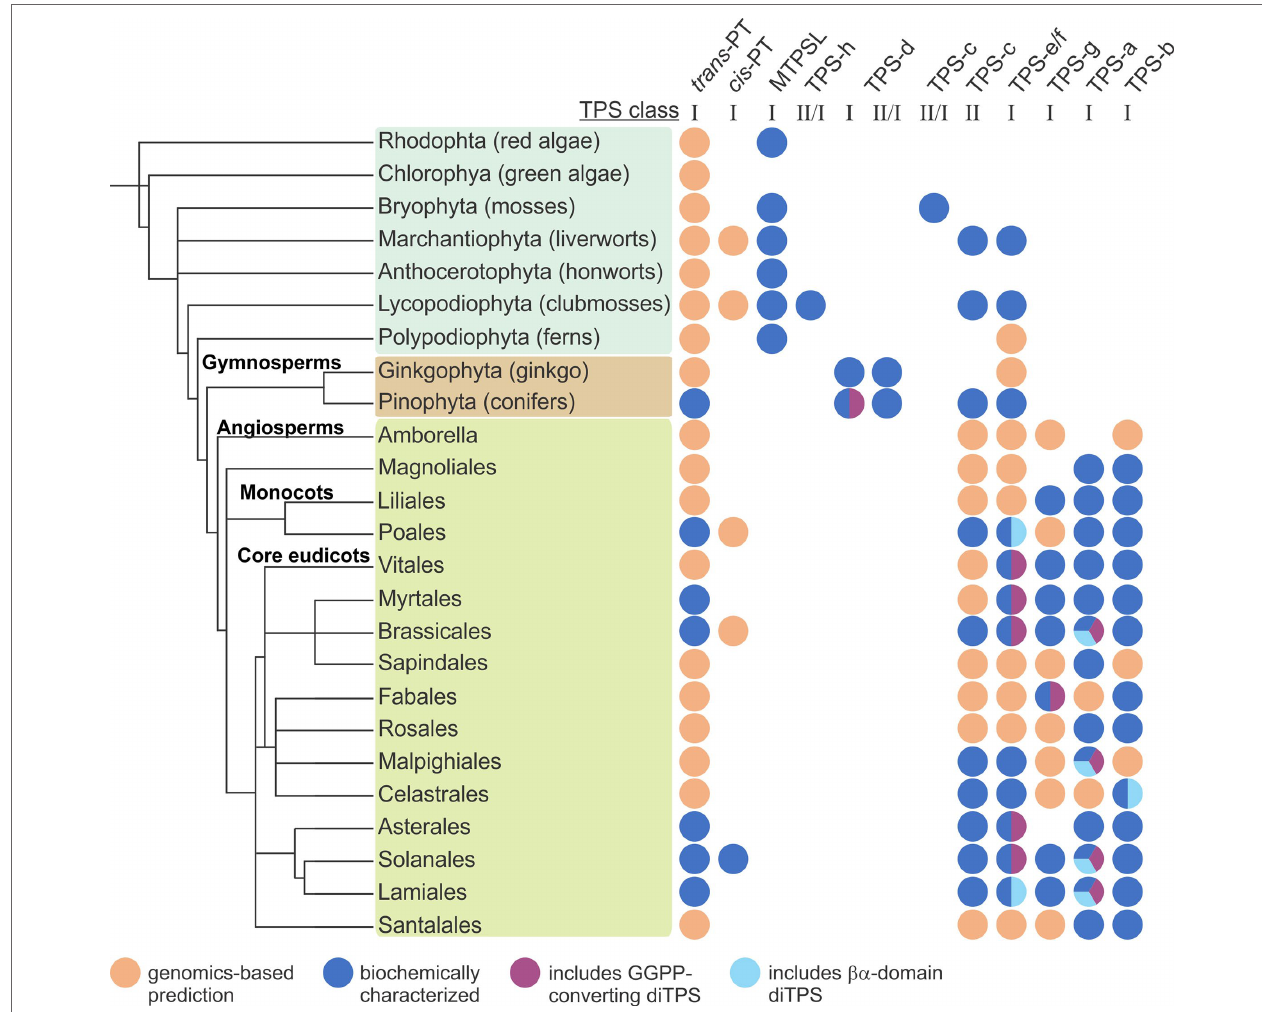
FIGURE 4 | Distribution of terpene-biosynthetic enzyme families across major orders across the plant kingdom. PT, prenyltransferases; MTPSL microbial-type terpene synthases (TPSs); TPS-h, Selaginella -specific bifunctional class II/I diterpene synthases (diTPSs); TPS-d, gymnosperm-specific class I mono-, sesqui-, di-TPSs, and bifunctional class II/I diTPSs; TPS-c, monofunctional class II diTPSs; TPS-e/f, monofunctional class I diTPSs; TPS-g, monofunctional class I mono-, sesqui-, and di-TPSs; TPS-a, monofunctional class I sesqui- and di-TPSs; TPS-b, monofunctional class I